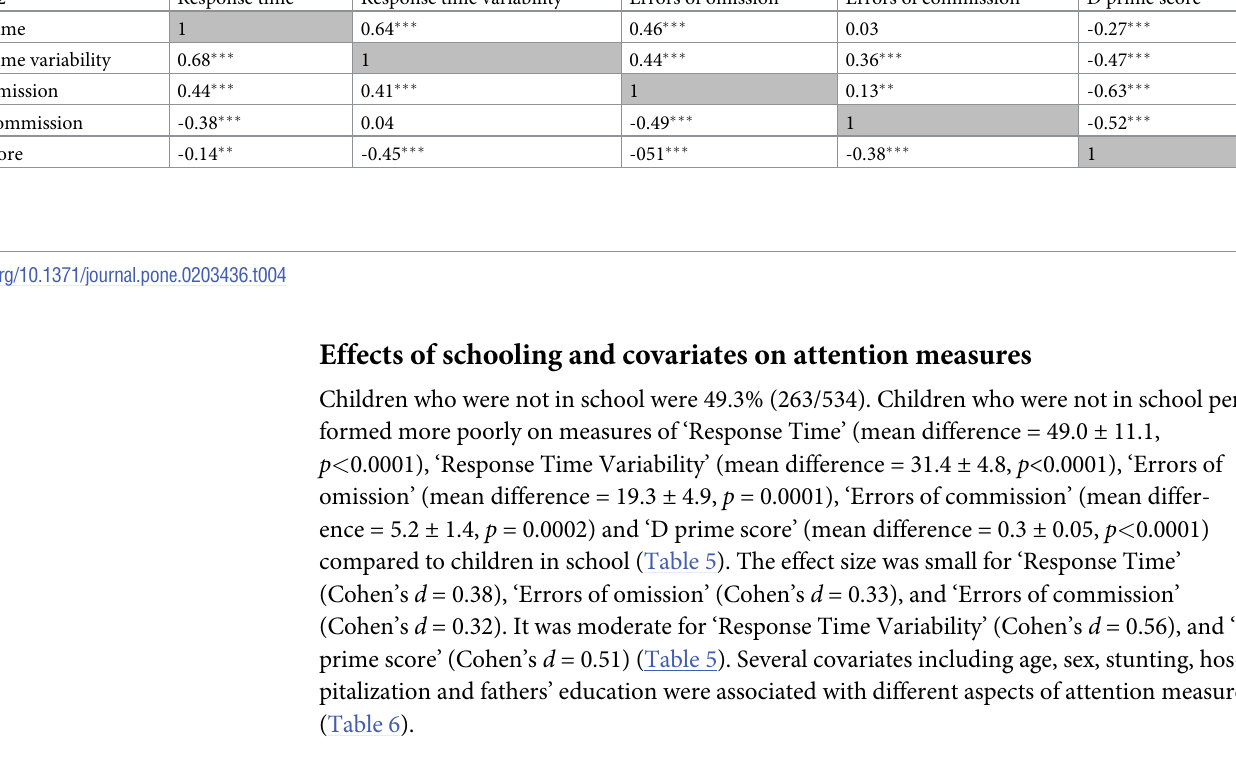
Table 4. Intercorrelations reliability coefficients between TOVA test measures as reported by children from the PROMISE Saving Brains study in Cascades health district, rural Burkina Faso. TOVA test conditions